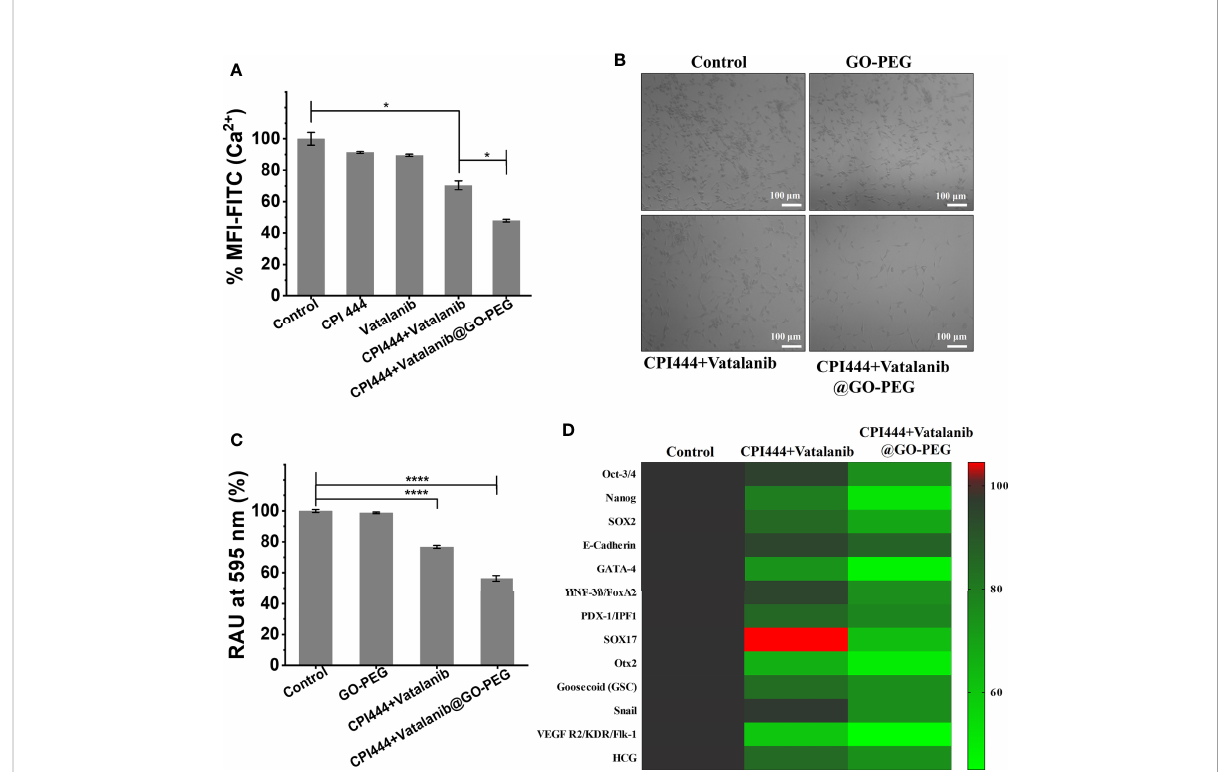
FIGURE 7 CPI444 and vatalanib-loaded GO-PEG affect the proliferation and stemness properties of GBM U87 cells. (A) Cellular calcium levels were estimated by FACS analysis using Fluo-4AM dye under different drug treatment conditions. (B) Colony forming assay of GBM U87 treated with untreated control, GO-PEG, CPI444 + vatalanib and CPI444 and vatalanib conjugated with GO-PEG. (C) Quantitation of colony forming assay, %RAU, relative absorbance units in percentage. (D) Heatmap depicting the expression levels of human pluripotent stem cell protein array for pluripotency and differentiation markers upon treatment with CPI444 and vatalanib loaded on GO-PEG with appropriate controls. MFI (Mean Fluorescence Intensity) in arbitrary units (AU); **** p < 0.0001 and * p <